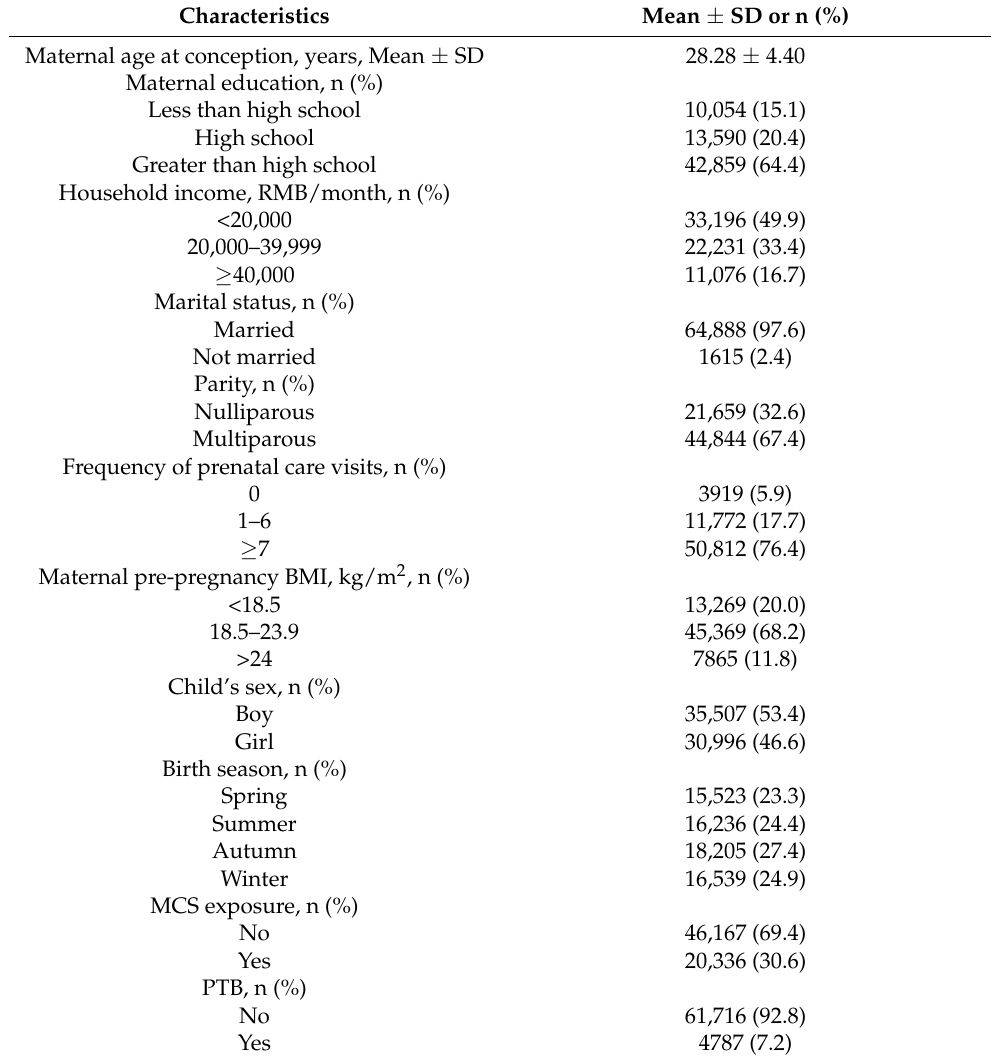
Table 1. Characteristics of the study participants (n = 66,503).